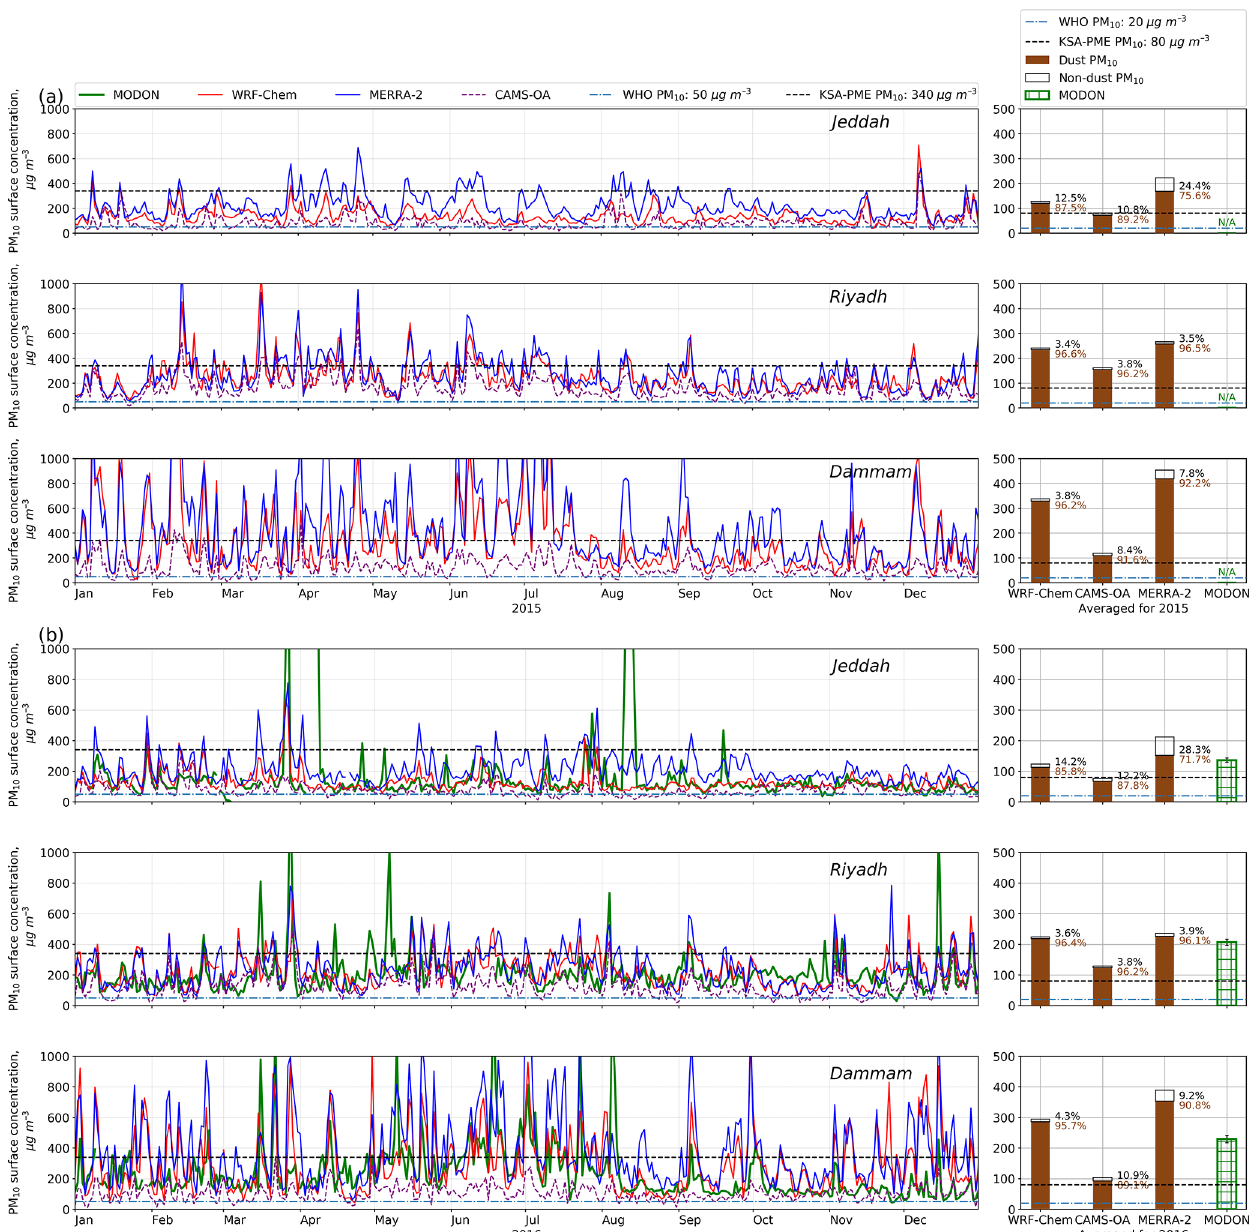
Figure 9. Left: WRF-Chem daily averaged PM 10 surface concentrations (µgm − 3 ) with the MODON observations as well as MERRA-2 and CAMS-OA at Jeddah, Riyadh, and Dammam. The dash-dotted line corresponds to the 50µgm − 3 WHO daily guideline. Right: stacked bars show the decomposition of the PM 10 annual mean surface concentrations into dust and nondust components. The dash-dotted line corresponds to the 20µgm − 3 WHO annual guideline. Numbers on the right-hand side of the WRF-Chem, CAMS-OA, and MERRA-2 bars show the contribution (%) of the dust and nondust components to the total PM 10 concentration. (a) 2015, (b)